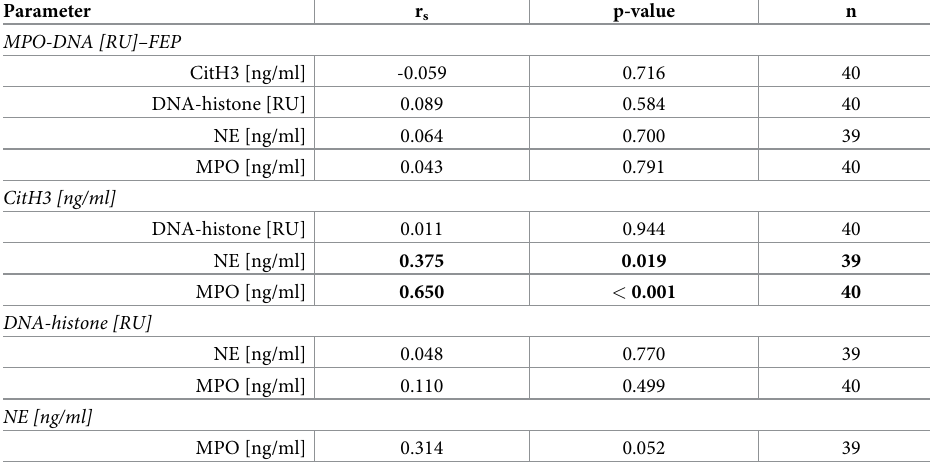
Table 3. Correlations between MPO-DNA complexes and parameters of neutrophil activation and NET forma- tion in plasma of AAA patients. Parameter r s p-value n MPO-DNA [RU]–FEP CitH3 [ng/ml] -0.059 0.716 40 DNA-histone [RU] 0.089 0.584 40 NE [ng/ml] 0.064 0.700 39 MPO [ng/ml] 0.043 0.791 40 CitH3 [ng/ml] DNA-histone [RU] 0.011 0.944 40 NE [ng/ml] 0.375 0.019 39 MPO [ng/ml] 0.650 < 0.001 40 DNA-histone [RU] NE [ng/ml] 0.048 0.770 39 MPO [ng/ml] 0.110 0.499 40 NE [ng/ml] MPO [ng/ml] 0.314 0.052 39 CitH3, citrullinated histone H3; DNA, deoxyribonucleic acid; FEP, final ELISA protocol; MPO, myeloperoxidase; NE, neutrophil elastase; r s , Spearman’s coefficient of correlation; RU, relative units. Citrate plasma samples of AAA patients were assessed for MPO-DNA complexes (by modified ELISA protocol) and for NE, MPO, DNA-histone complexes and citH3. Correlation between parameters is expressed by Spearman’s